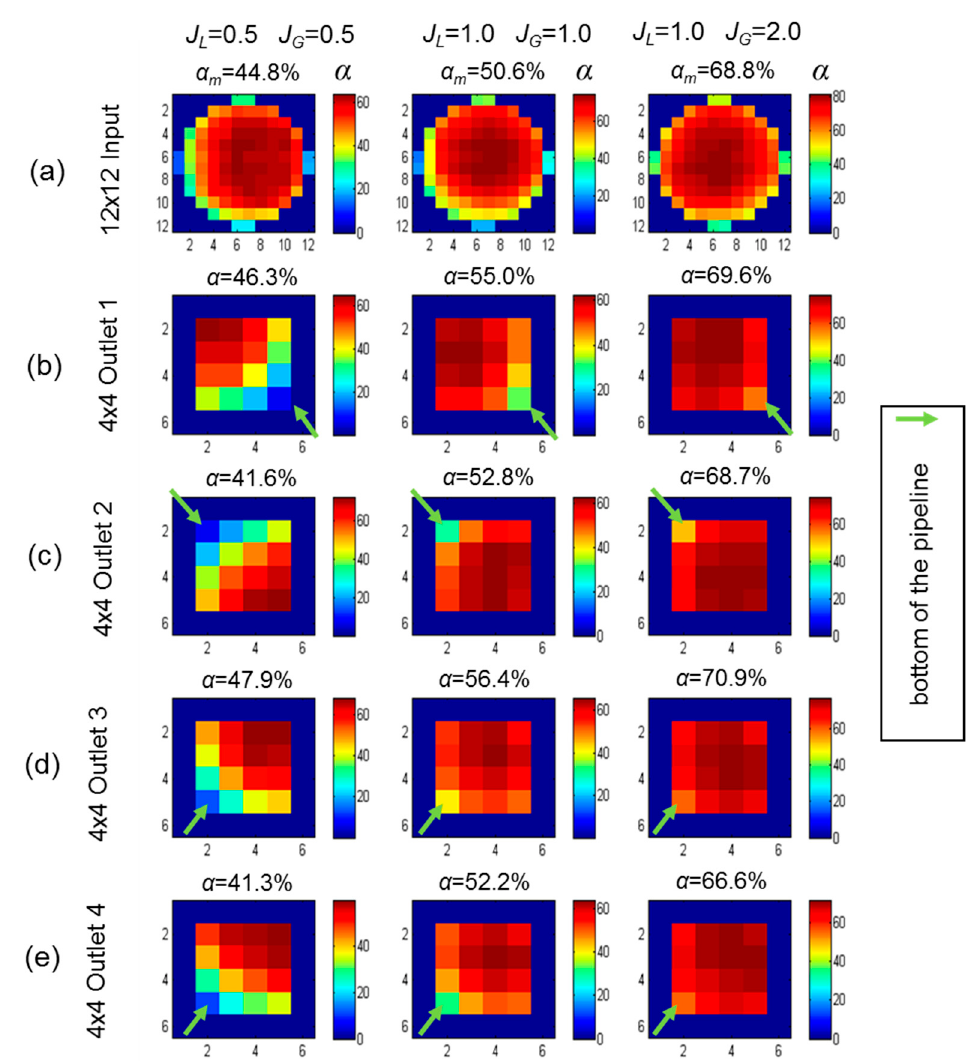
Figure 12. Mean axial void fraction ( α m ) measured in 30 s by WMS in three set of superficial velocities: J L = 0.5 m/s and J G = 0.5 m/s; J L = 1.0 m/s and J G = 1.0 m/s; and J L = 1.0 m/s and J G = 2.0 m/s. ( a ) Input and